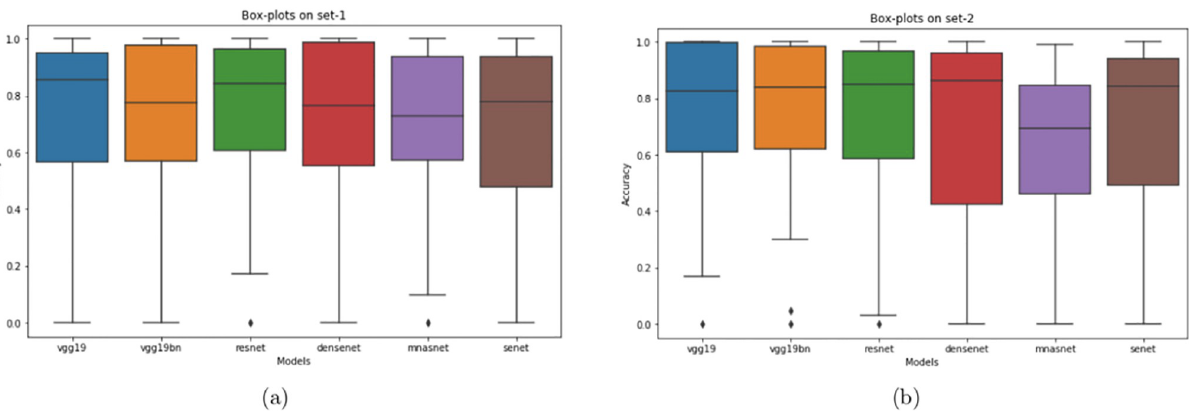
PLOS ONE | https://doi.org/10.1371/journal.pone.0236452 July 30,